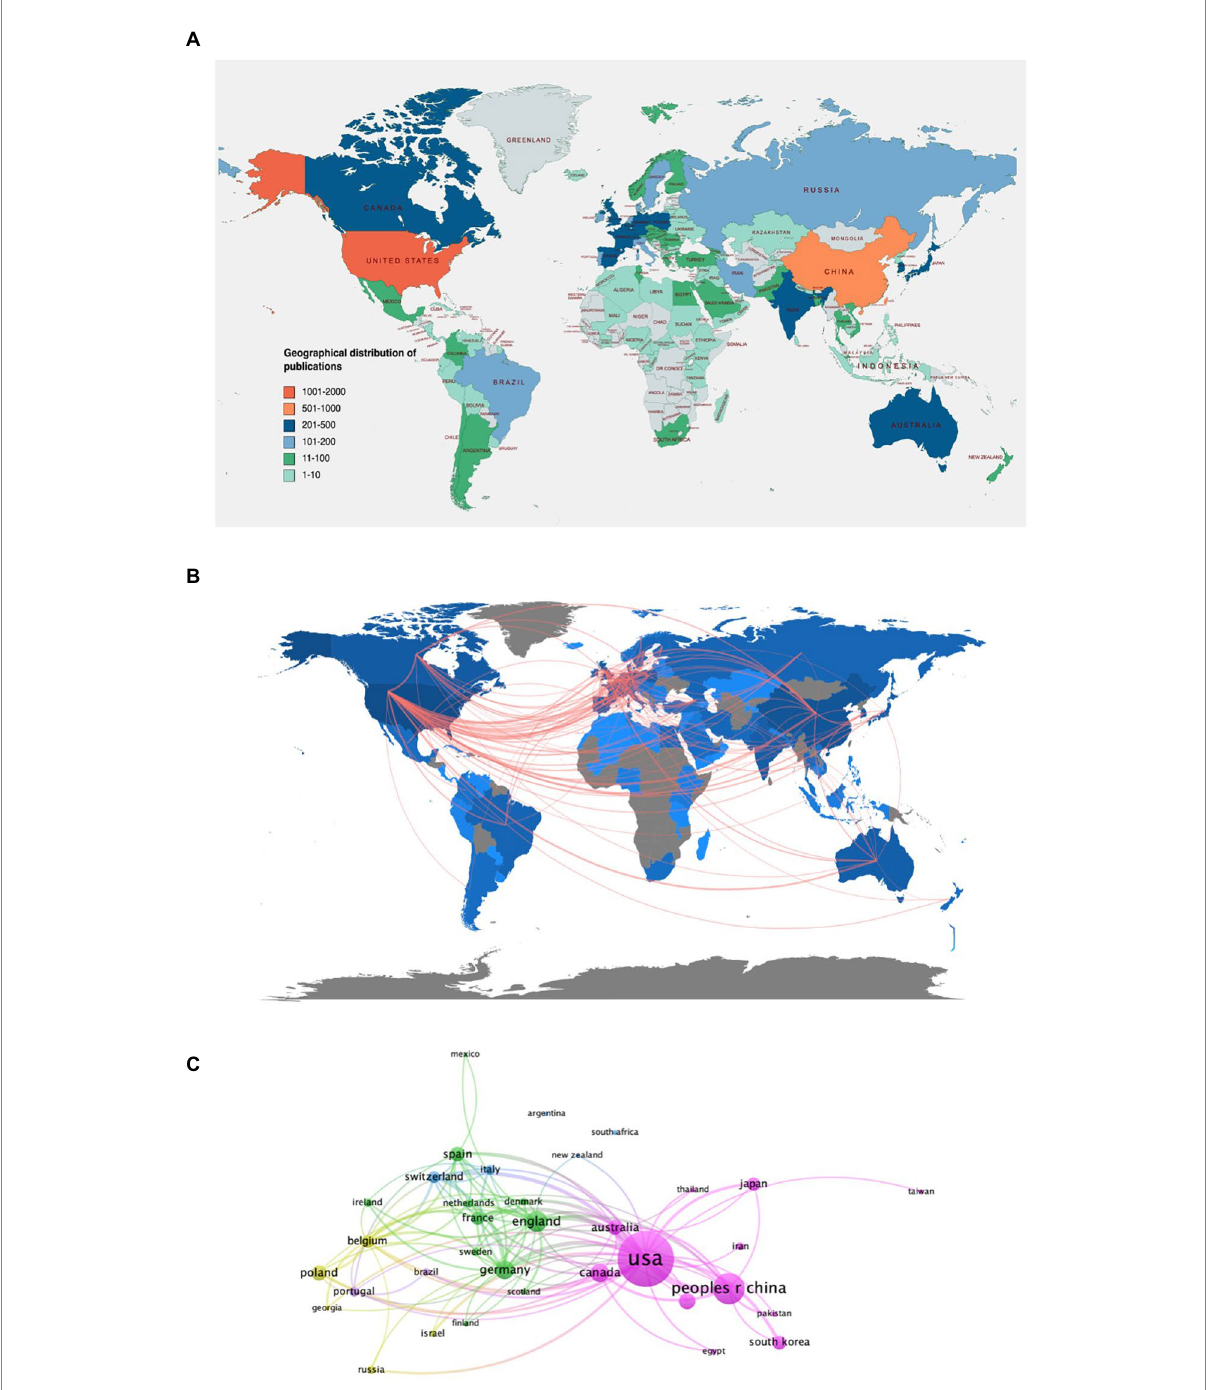
FIGURE 3 (A) World map of the global distribution. (B) World map of the global collaborations among countries in the field of PT therapy on bacterial infection. The thicker the red line, the more frequent the collaboration. (C) Collaboration networks among countries or regions based on VOS